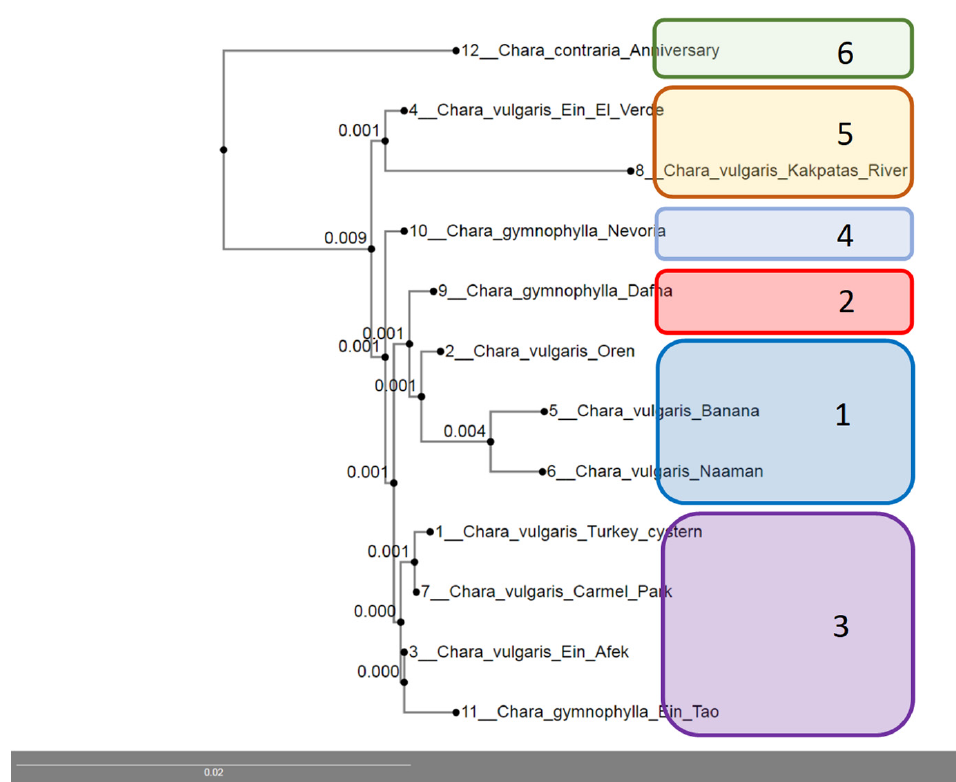
Figure 8. UPGMA Phylogenetic tree comparing the mat K sequence of charophyte species in Kazakhstan with those of Israel species. The scale bar refers to evolutionary distances in substitutions per site.